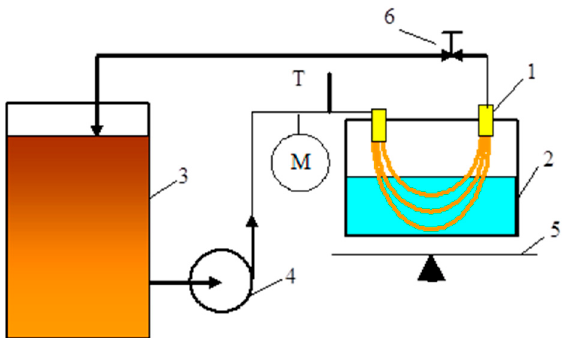
Figure 1. MF process experimental setup; 1—submerged MF module, 2—permeate tank, 3—feed tank with temperature regulator, 4—peristaltic pump, 5—balance, 6—valve (pressure regulator), M—manometer, T—thermometer.